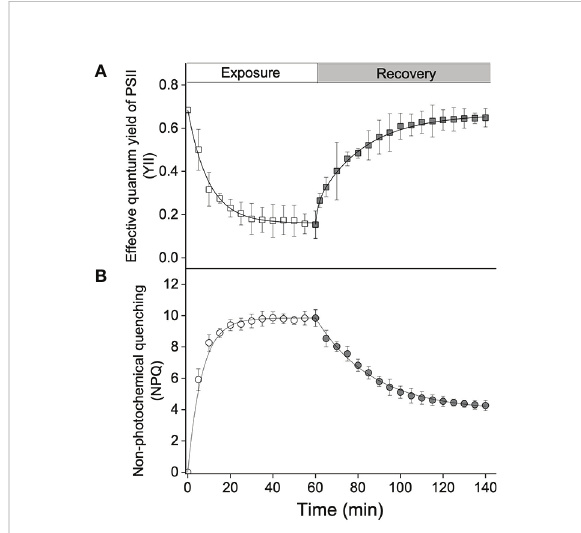
FIGURE 1 Kinetics of the effective quantum yield of photosystem II (PSII) (A) (Y(II)) and (B) non-photochemical quenching (NPQ), in Sargassum thunbergii during high light exposure for 60 min (1,200 m mol photons m – 2 s – 1 , white points) followed by an 80- min recovery (darkness, gray points). Each curve represents the fi t (all R 2 -values > 0.95) to the model of Ocampo-Alvarez and Garc ı ́ a-Mendoza (2013). Data represent the mean ± SD ( n =